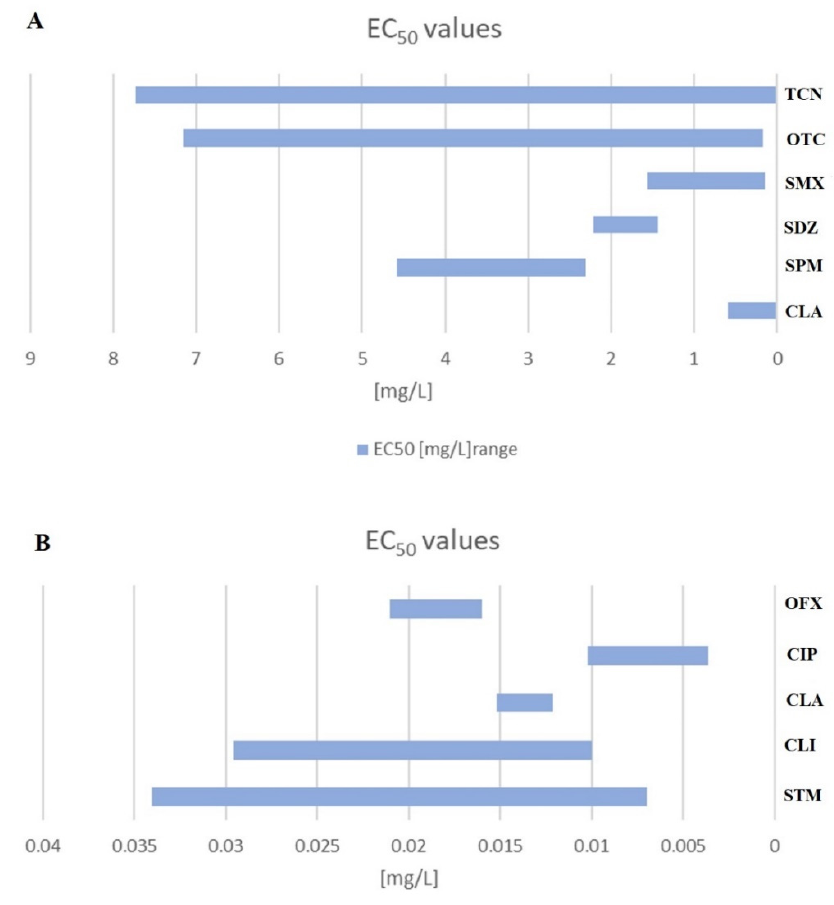
Figure 1. The summary of the EC 50 values expressed in mg/L of the ten most toxic antibiotics towards freshwater and marine green algae ( A ) and cyanobacteria ( B ) (detailed information can be found in Table S1). (CLA—clarithromycin, CLI—clindamycin, CIP—ciprofloxacin, OFX—ofloxacin, OTC—oxytetracycline, SDZ—sulfadiazine, SMX—sulfamethoxazole, SPM—spiramycin, STM—streptomycin, TCN—tetracycline).